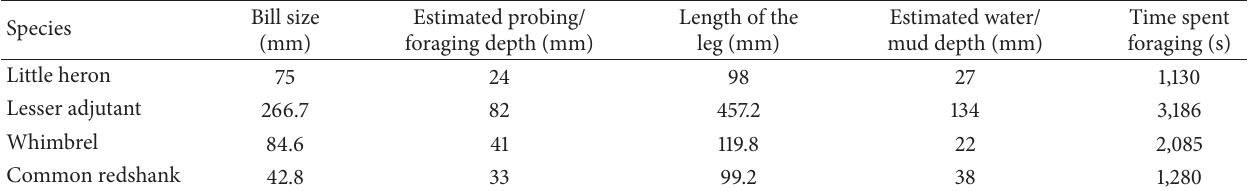
Table 3: Summary of bill size, average estimated probing depth, length of leg, average estimated water/mud depth per year, and average time spent foraging by shorebirds and water birds.